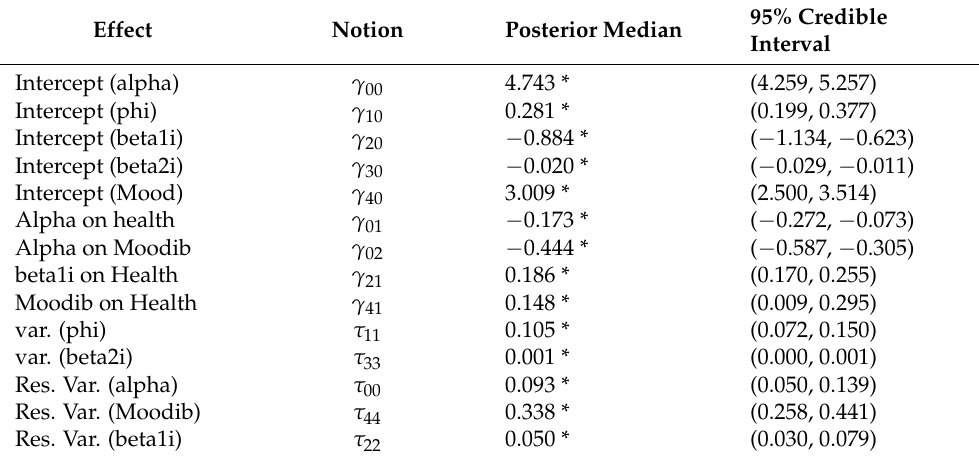
Table 2. Estimates and 95% credible intervals for residual dynamic structural equation modeling (RDSEM) of emotional exhaustion with a linear